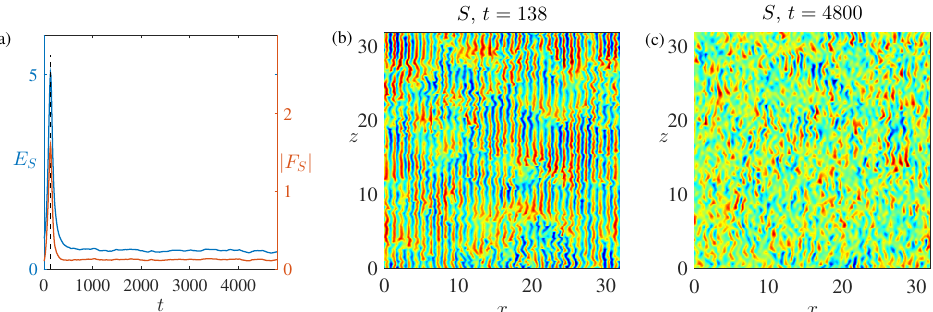
Figure 5. Results from a 32 (cid:96) opt × 32 (cid:96) opt simulation for Ra = 1.1. ( a ) Evolution of the total energy E S and the salinity flux | F S | with time. The dashed line marks t = 138, where both quantities peak. ( b ) The finger-dominated state at t = 138. ( c ) The instantaneous statistically steady state at t = 4800, the end of this simulation. Distances are measured in units of (cid:96) opt , the wavelength of the optimal